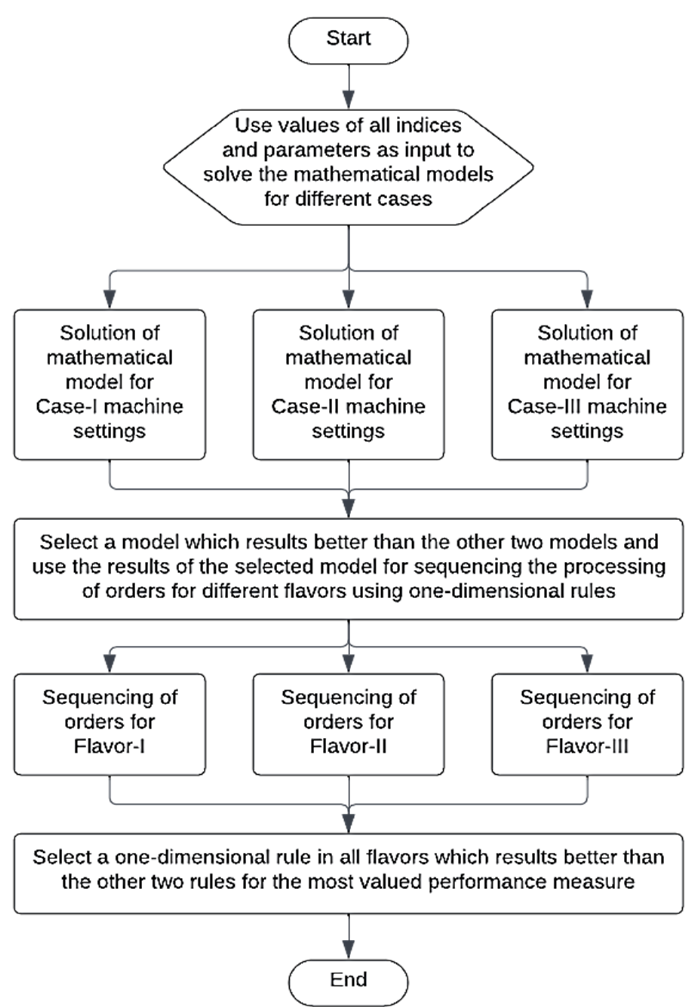
Figure 2. Optimal solution algorithm.